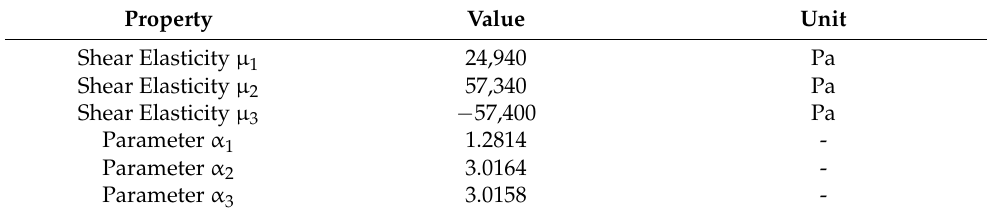
Table 1. Ogden third order hyperelastic material model parameter table. Property